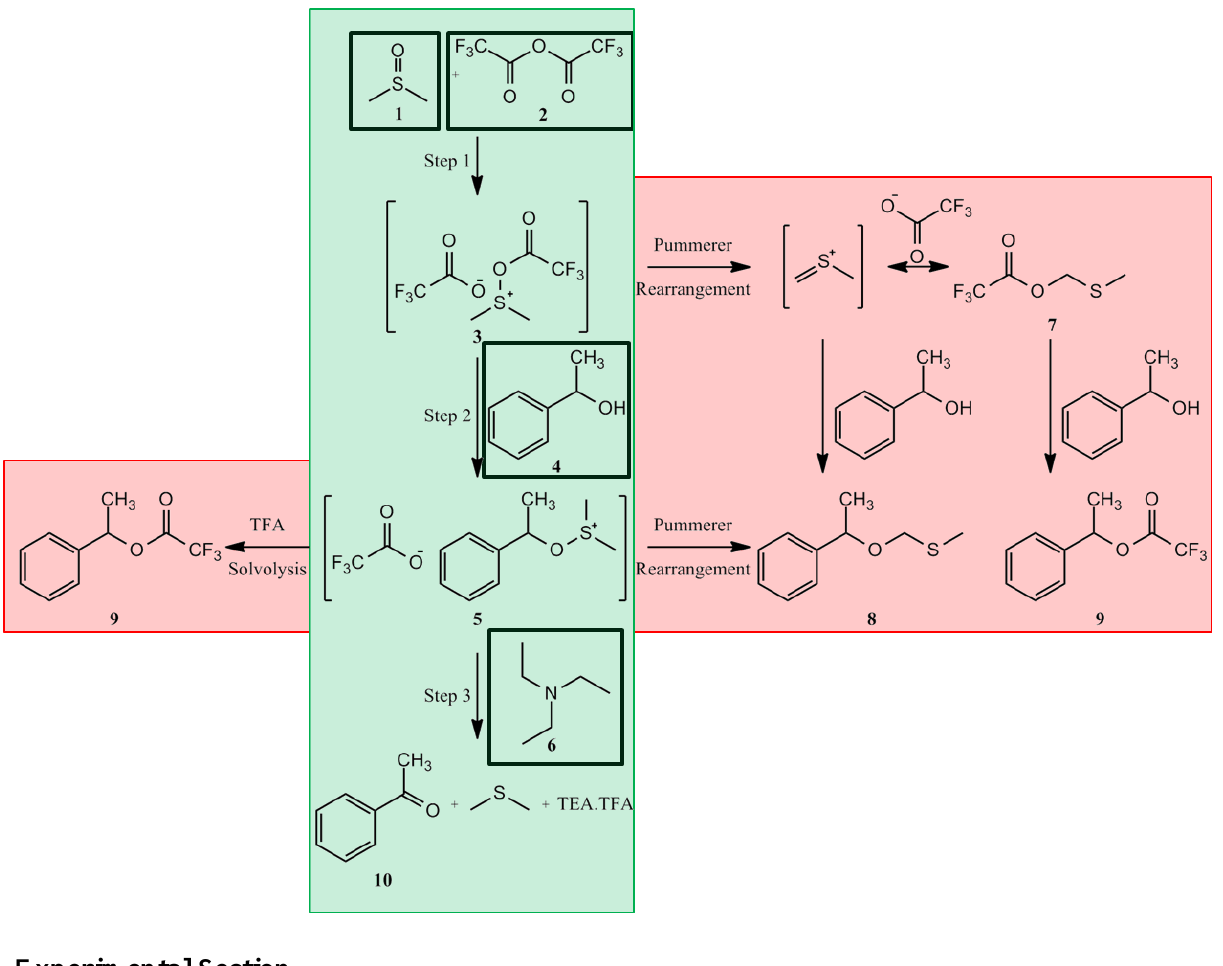
Figure 2. The Swern oxidation. The center column (green background) shows the desired chemical path, with added reagents shown in black boxes. The outer columns (red background) show the potential chemical pathways for side-product formation ( 8 and 9